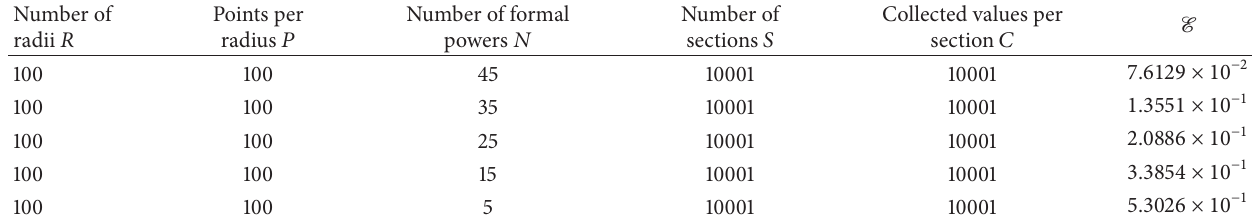
Table 16: Relation between the error E and the number of formal powers 𝑁 , when 𝜎 = 2 + sin 5(𝑥 + 𝑦) .